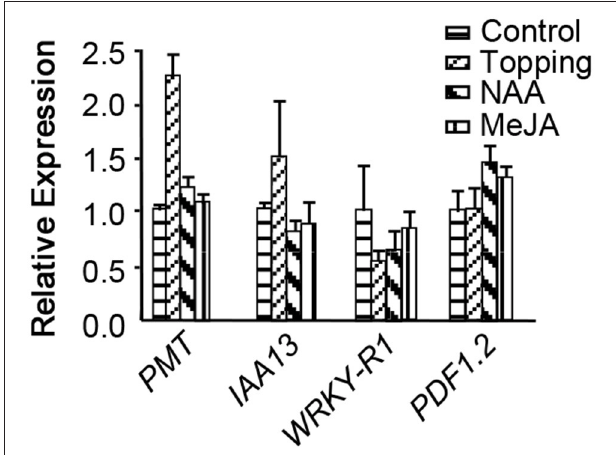
FIGURE 1 | The expression of PMT, IAA13, NtWRKY-R1, and PDF1.2 in response to MeJA, NAA, and topping. Values are given as means ± SD relative to the values. The respective control expression levels set at